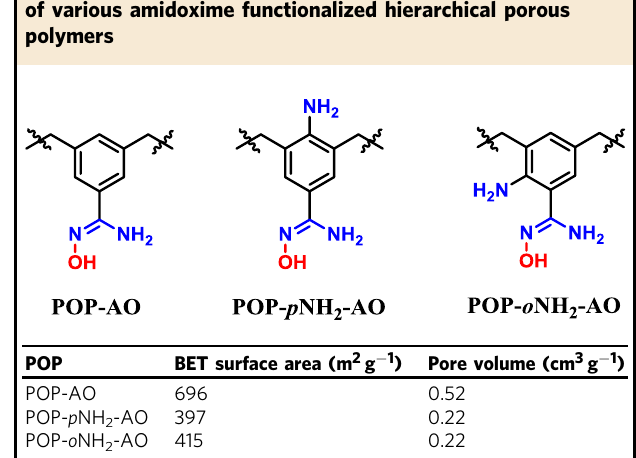
Table 1 Structure of building units and textural parameters of various amidoxime functionalized hierarchical porous